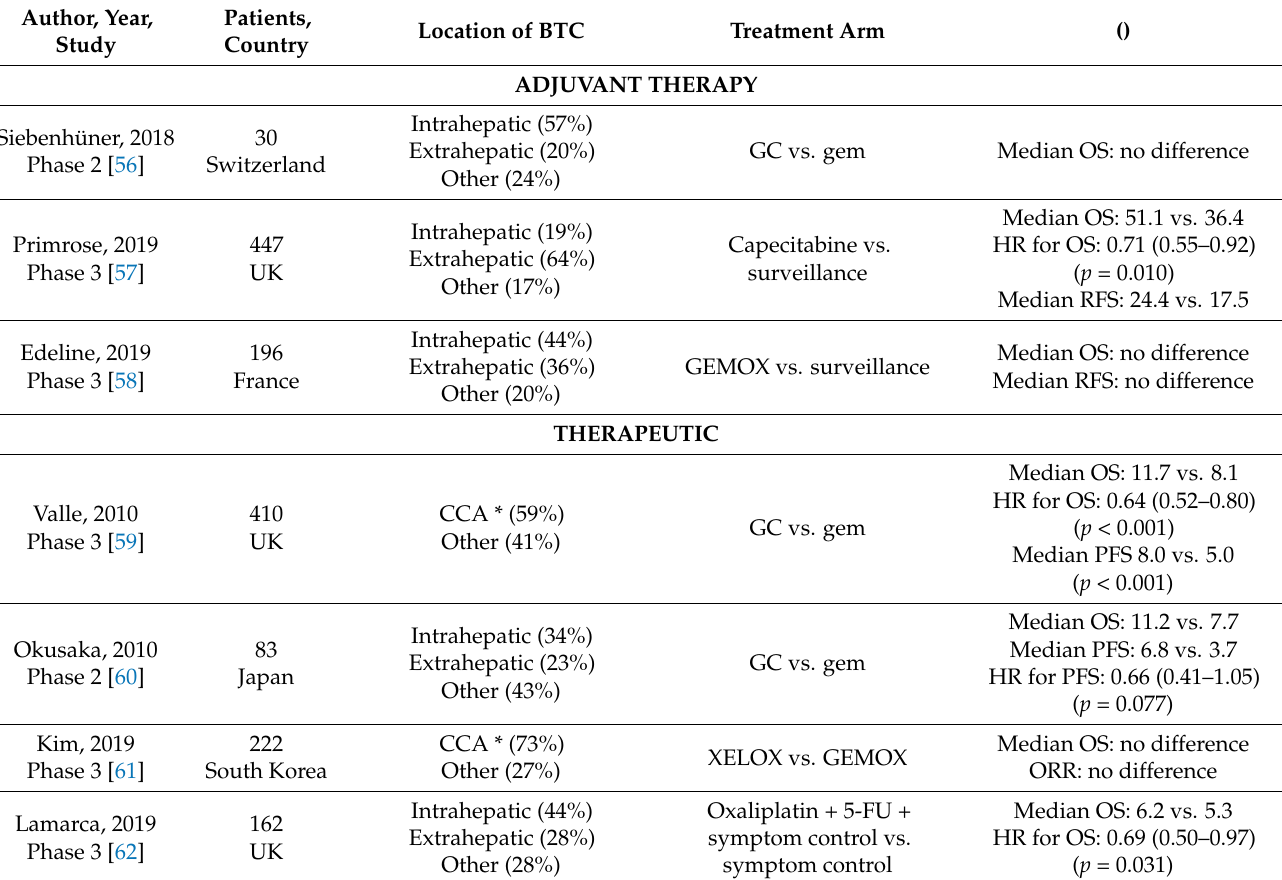
Table 2. Chemotherapy Regimens and